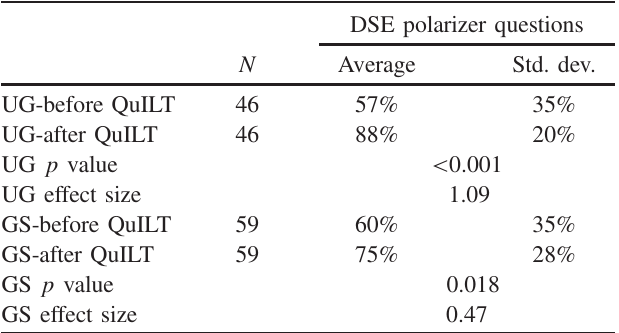
TABLE V. Performance of undergraduate (UG) and graduate students (GS) on the DSE polarizer questions before and after working on the DSE QuILT and p values comparing the performance before to after working on the DSE QuILT for each group (obtained via a simple t test) as well as effect sizes (Cohen ’ s d ). N refers to the number of undergraduate or graduate students. Std. dev. refers to standard